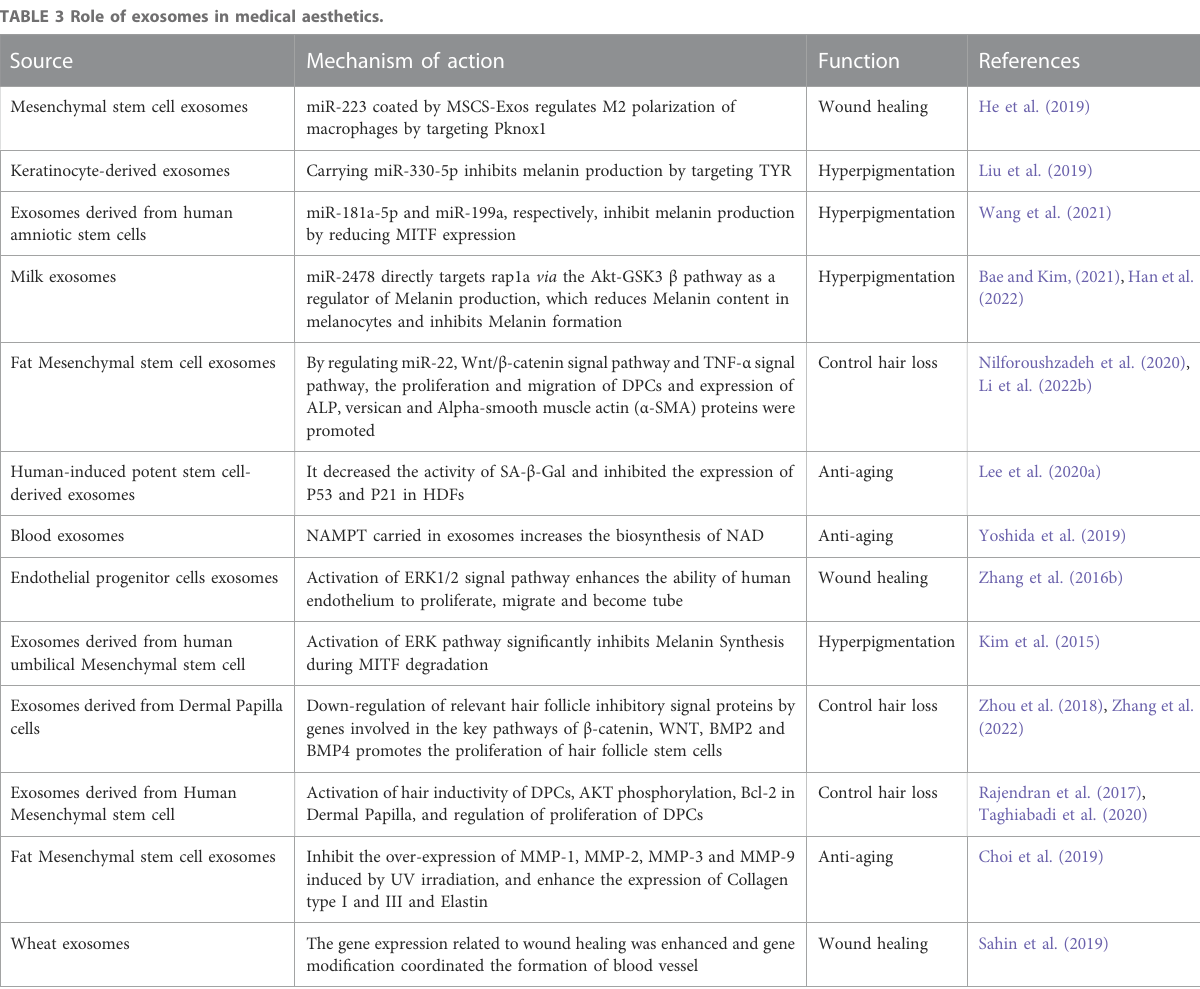
TABLE 3 Role of exosomes in medical